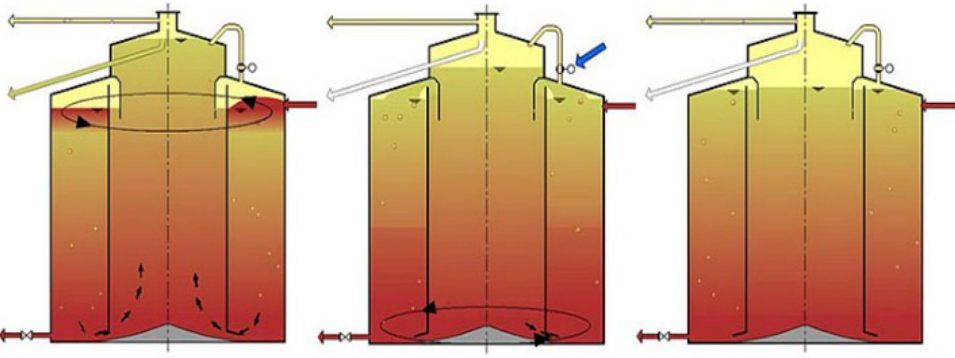
Figure 6. A schematic section of the digester plant, from the left: before, during and after